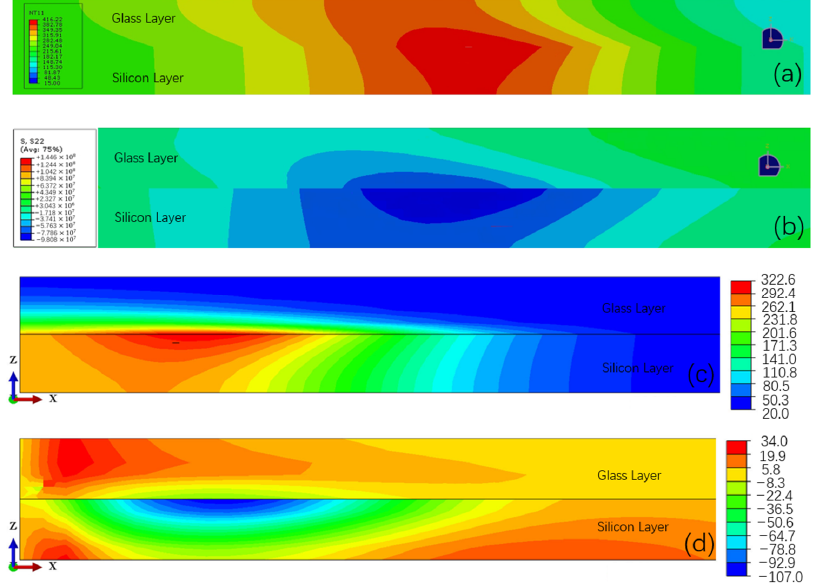
Figure 6. ( a ) Temperature field distribution at the low speed scanning inlet. ( b ) Distribution of the stress field at low speed incision. ( c ) Temperature field distribution at the high speed scanning inlet, ( d ) Distribution of the stress field at high speed incision. Figure 7c,d shows the temperature field and stress field distribution on the upper surface of the glass layer and the lower surface of the silicon layer at a high speed scanning time of 0.175 s. At this point, after the crack started at the cut entrance, the distance be- tween the laser spot and the leading edge of the crack increased rapidly. The stress field distribution showed that the glass layer had the highest stress value near the interface, while the silicon layer had the highest stress value near the outer surface. This was basi- cally consistent with the stress distribution and shape of the crack’s leading edge in the low-speed scanning, but the crack’s leading edge span was significantly increased. Figure 7. ( a ) Low speed temperature field distribution during steady expansion phase. ( b ) Distribu- tion of the low speed stress field in the stable expansion stage. ( c ) High speed temperature field distribution during the steady expansion phase. ( d ) Distribution of the high speed stress field in the stable expansion stage.